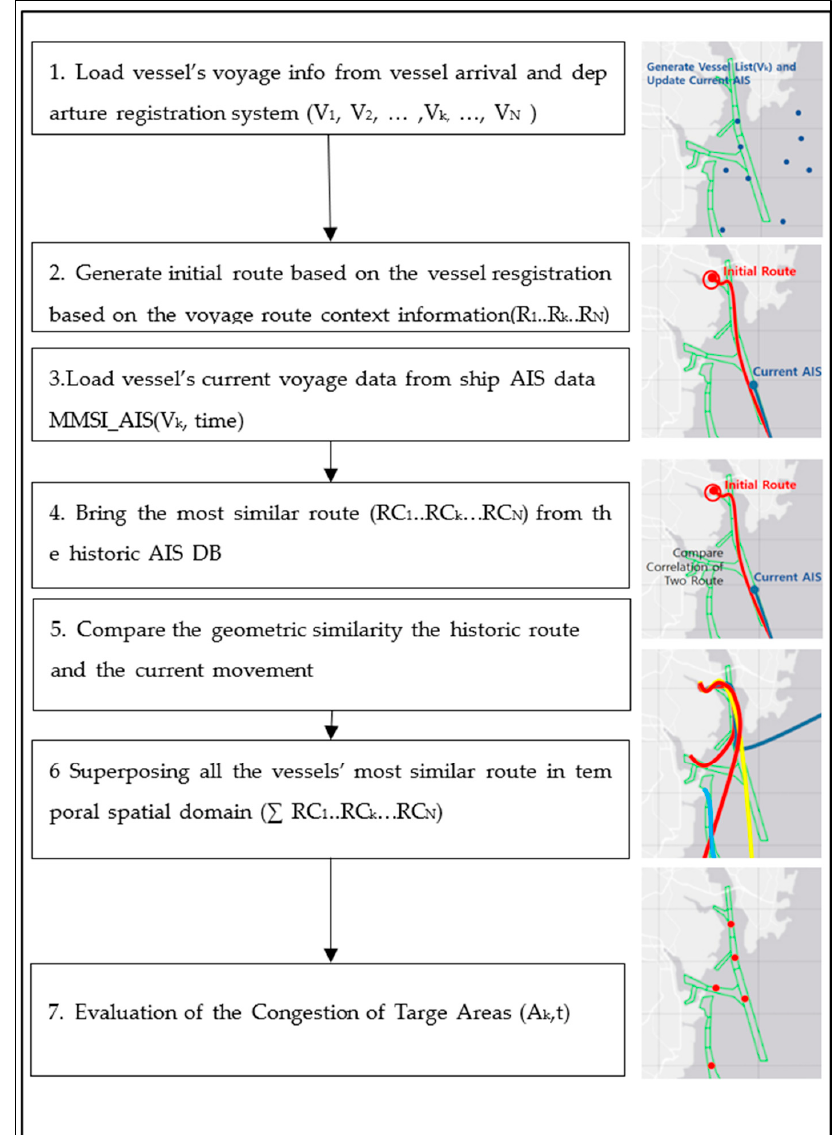
Figure 6. Congestion forecast process.